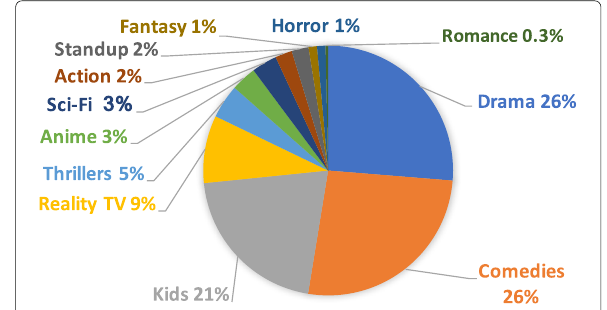
Fig. 1 Genre distribution in the TVSM dataset